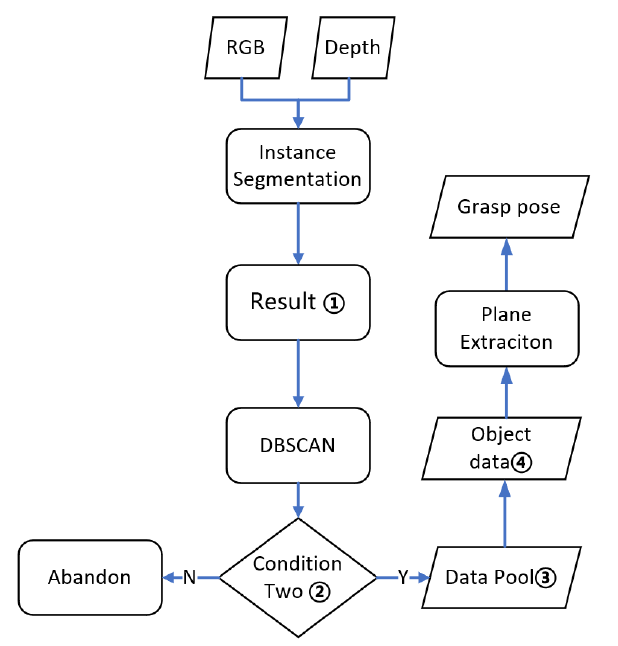
Figure 2. The overall processing of the robotic grasping method in this paper.